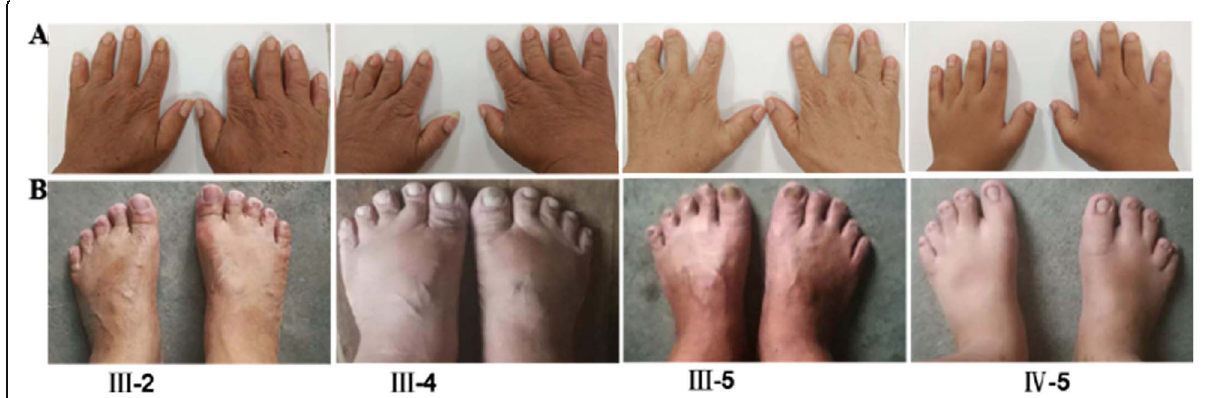
Fig. 3 Features of other affected family members with brachydactyly type A1 (BDA1). a showing shortened fingers and radial deviation of the second or/and third finger (III-2, III-5, IV-5) and flexion contracture of the 4nd finger (III-5). b showing abnormally shortened toes